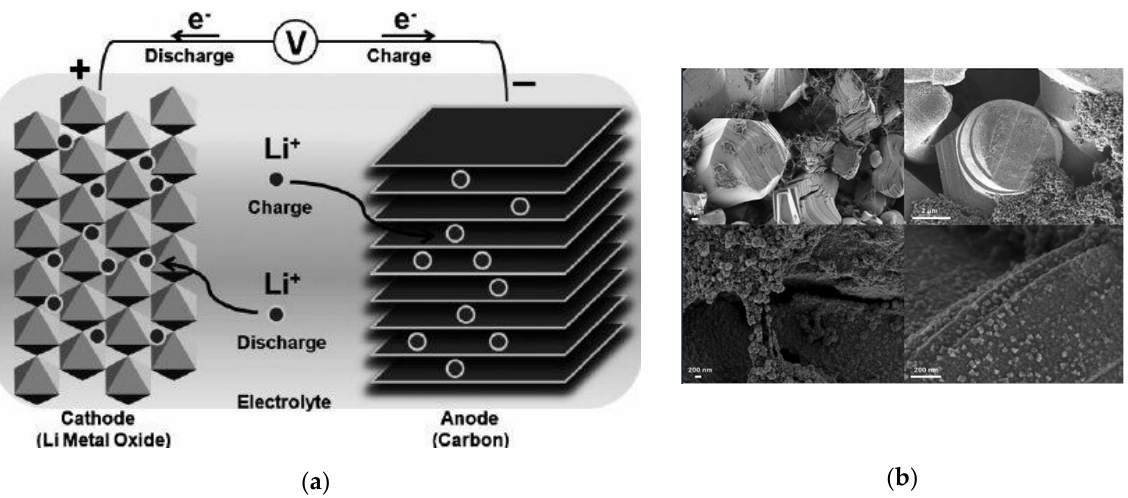
Figure 2. ( a ) A schematic diagram depicting the process and chemistry of a Li-ion cell [4,13] . Reprinted with permission from [13] . Copyright 2009 Wiley. ( b ) Scanning electron microscopy of cathode, anode, binder, and separator [14] . Reprinted from an open access blog [14] .